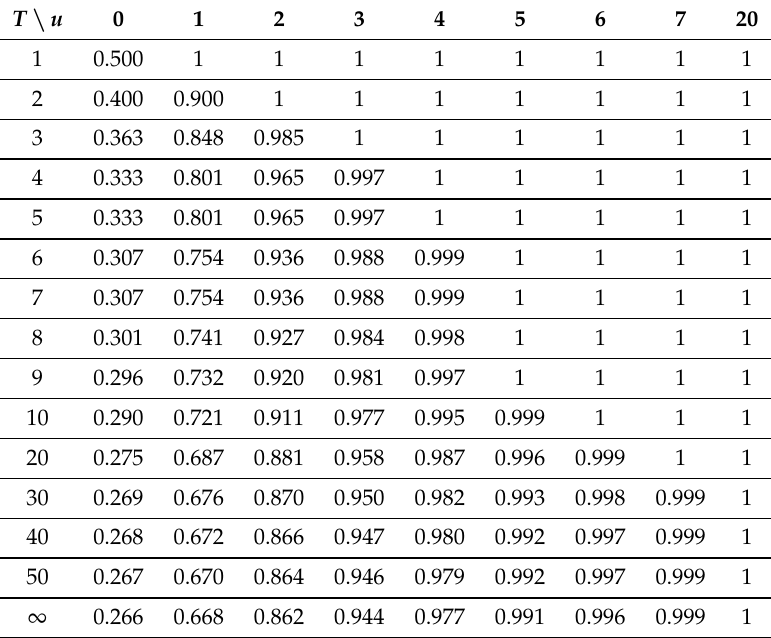
Table 7. Values of ϕ ( u , T ) and ϕ ( u ) for the model of Example